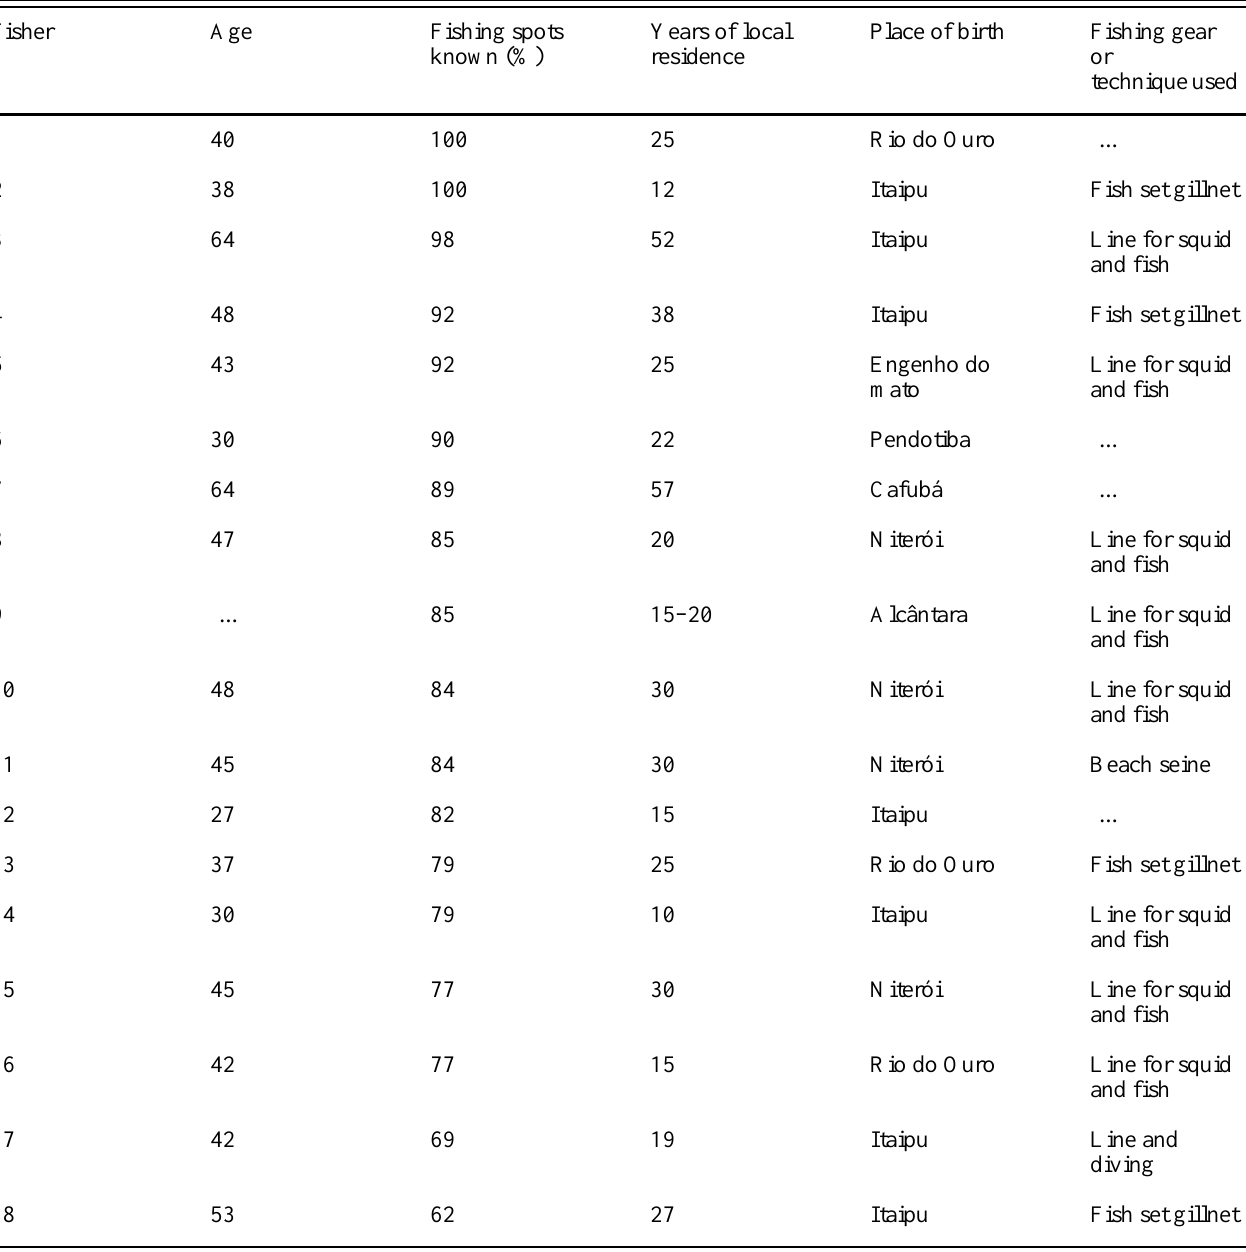
Table 2 . Results of interviews performed at Itaipu, Niterói, Rio de Janeiro State, Brazil. Fisher Age Fishing spots